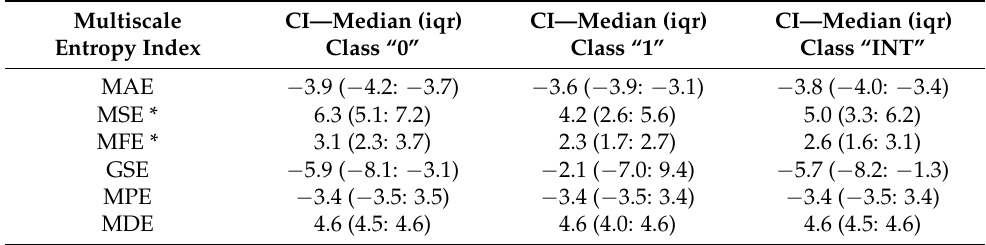
Table 7. Descriptive statistics (median and IQR) for all the entropy indexes and the classes considered (“0-1-int”) concerning the complexity index (CI) with the corresponding slope (+1 if positive − 1 if negative). Stars (*) denote significant differences between class “0” and “1” (Mann-Whitney Test p -value < 0.05, after Bonferroni